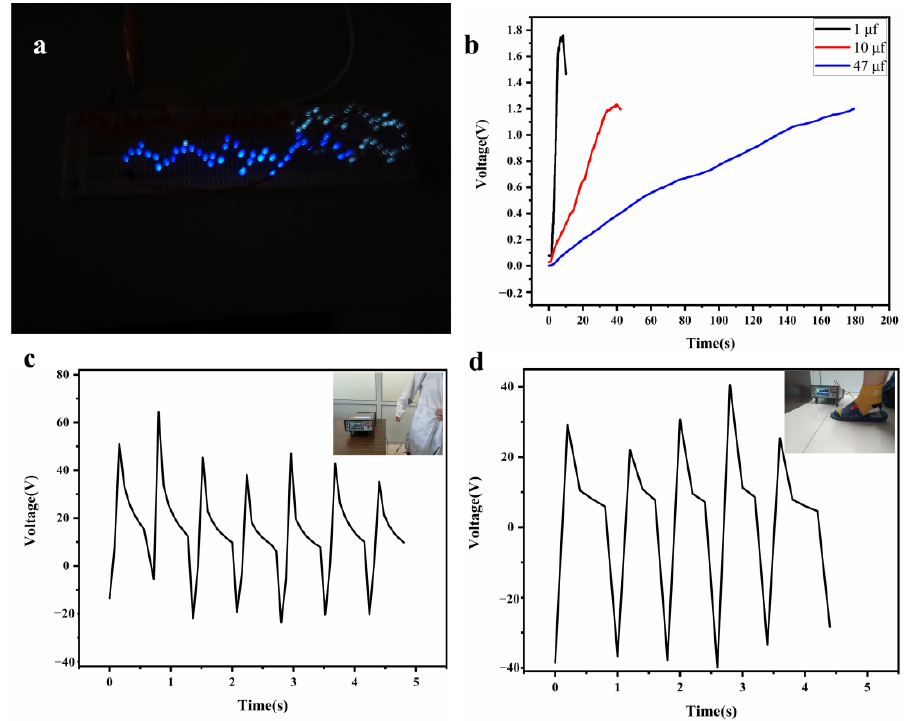
Figure 8. ( a ) 110 commercial led tandem light chains lit by TENGs; ( b ) three commercial capacitors to 1.2 V, respectively, charged by TENGs; ( c ) mechanical energy of the swing arm movement collected by TENGs; ( d ) mechanical energy from walking motions collected by